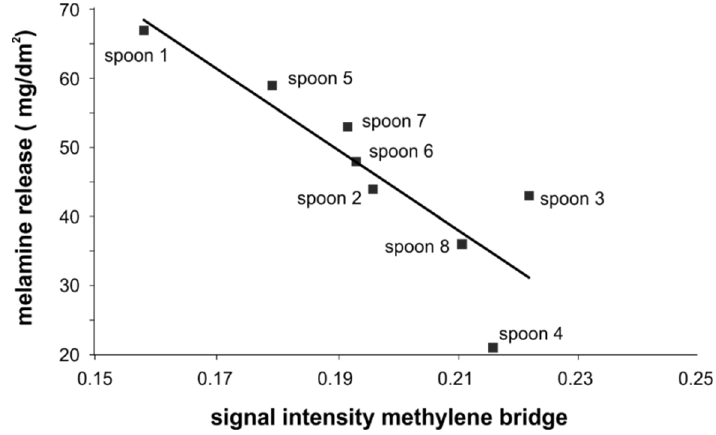
Figure 10. Dependence of the melamine release (3rd release) on the number of methylene bridges in the resin, solid line: fit of data.